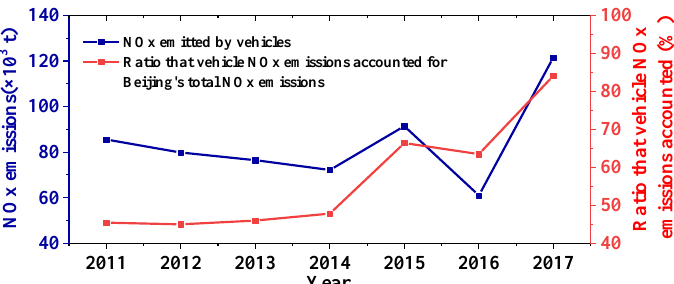
Figure 1. The annual NO X emissions of vehicles in Beijing from 2011 to 2017 and the percentage of vehicles emitting NOx over total NOx emissions in Beijing. (NO X emission data source: Beijing Municipal Ecological Environment Bureau).